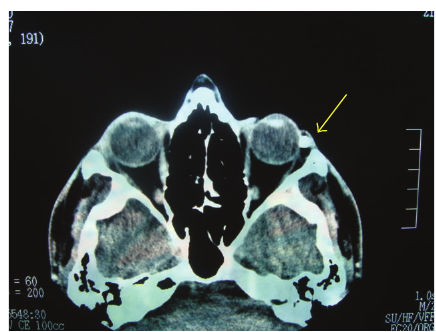
Figure 2: Episcleral osseous choristoma on the lateral canthus of left eye in computed tomography (arrow).